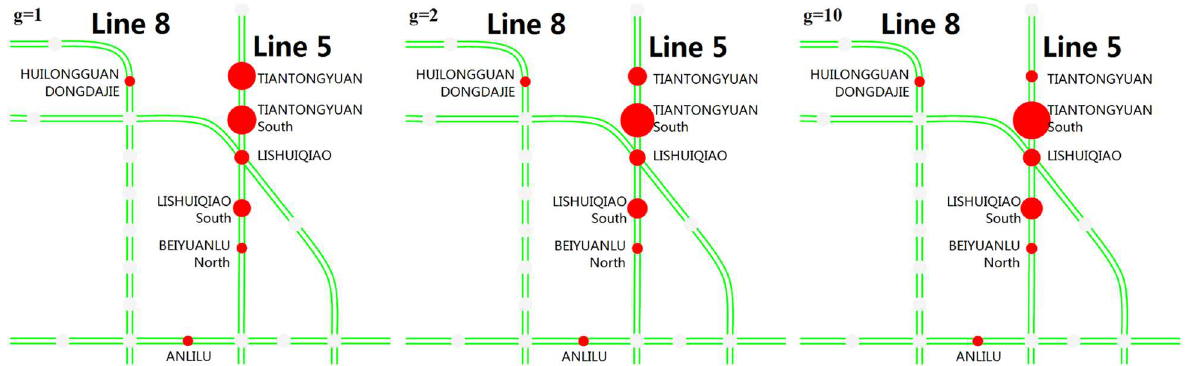
Fig 19. The main stations that passengers choose as their alternative origin stations after TIANTONGYUAN station is closed. The red circles represent the alternativeorigin stations. The size of each circle represents the numberof passengers who choose that station, and a larger radius indicatesrelativelymore passengers.